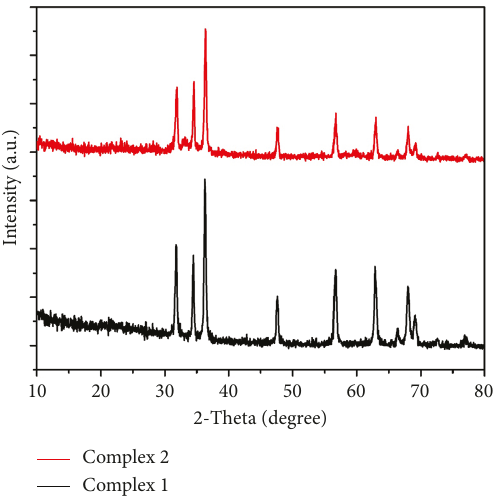
Figure 4: XRD patterns of complexes (1) and